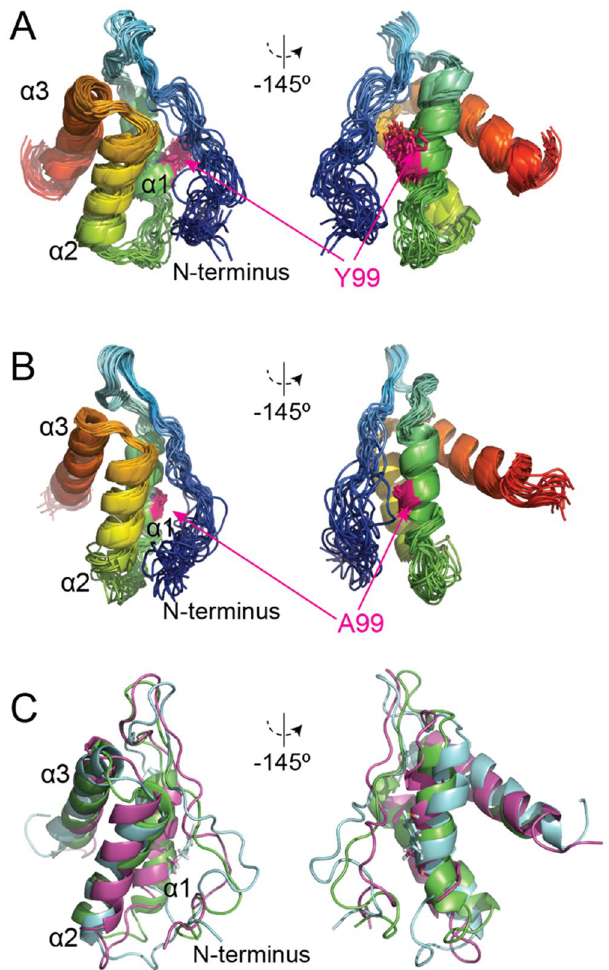
Figure 4. Details of MD1 and variant MD1 Y99A structures obtained by NMR spectroscopy. ( A ) Cartoon representations of the structure ensemble of the 20 best solution structures of MD1 and ( B ) MD1 Y99A variant. ( C ) Comparison of the representative NMR solution structures of MD1 (cyan) and MD1 Y99A (purple) with the crystal structure of MD1 from B. glumae (green) (PDB code 2ES4 10